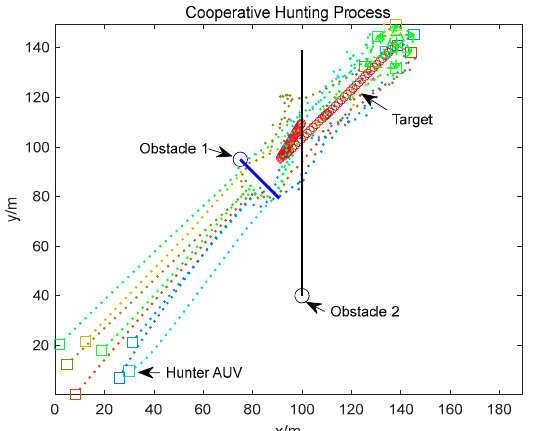
Figure 9. HAP-IAPF method in dynamic environment: ( a ) The initial position of hunter AUV; ( b ) process of passing obstacles; ( c ) position distance between formation center and the target; ( d ) distances between each agent and obstacle 1 and 2.